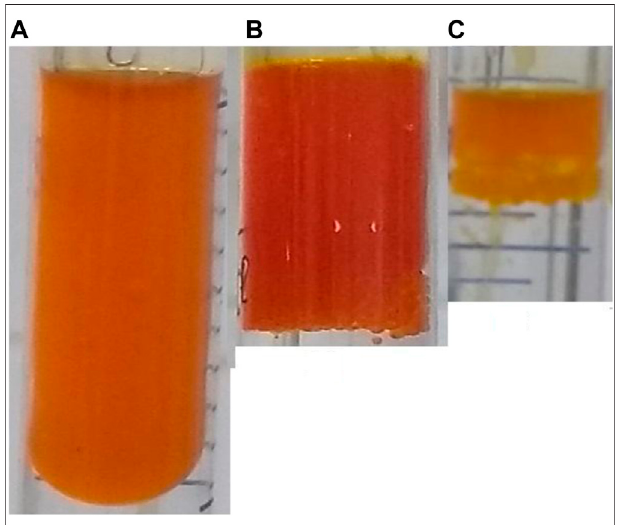
FIGURE 4 | Essential oil obtained by hydrodistillation of T. riparia leaves (A) , fl ower buds (B) , and stems (C) — Source: Chemical Laboratory of Natural Products-Paranaense University-UNIPAR,